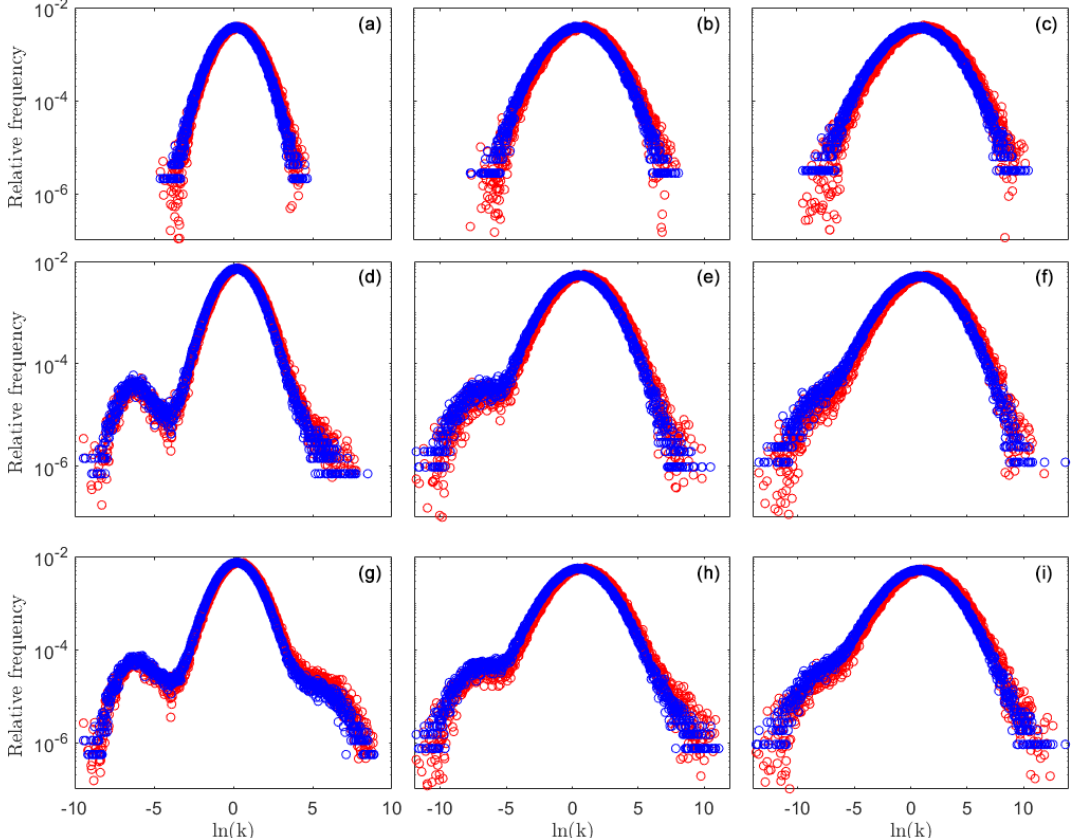
Figure 1. Relative frequency distributions f (y ij ) (blue circles) and f (ny ij ) (red circles) for a tracer test performed on the conductivity field prior to reaction and those associated with reactive simulation times of 10 and 20min. Results correspond to σ 2 right columns, respectively) and to t = 0 (a–c) , 10 (d–f) , and 20min (g–i) . Mean and variance of these distributions are listed in Table